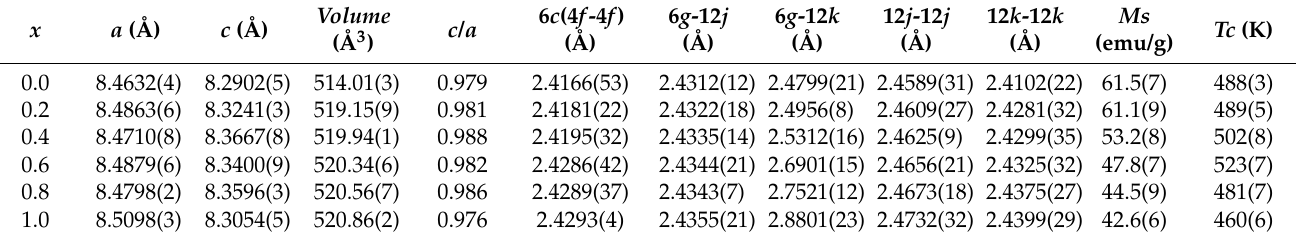
Figure 2. Lattice parameter a and c with the unit cell volume of Dy 2 Fe 16 Ga 1 − x Nb x as a function of x , Nb content. Table 1. Lattice parameters, volume, site occupancy, Ms , and Tc of Dy 2 Fe 16 Ga 1 − x Nb x